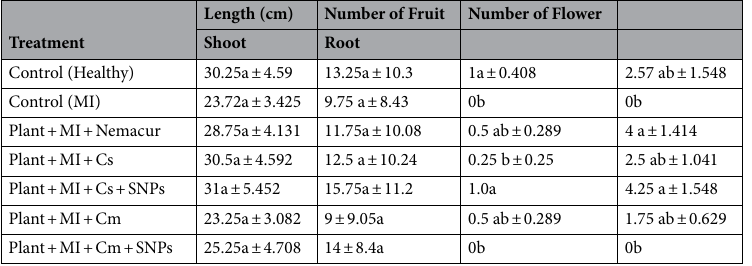
Table 4. The effect of C . sinuosa (Cs), C. mediterranea (Cm) macroalgal extracts, synthesized silver nanoparticles and Nemacur 400 EC on some growth parameters of tomato plants infected with M. incognita (MI) after 60 days in a pot experiment. Data are means of 10 replicates. Data expressed as mean ± SD. Values followed by the same letter(s) are not significantly different at p ≤ 0.05.